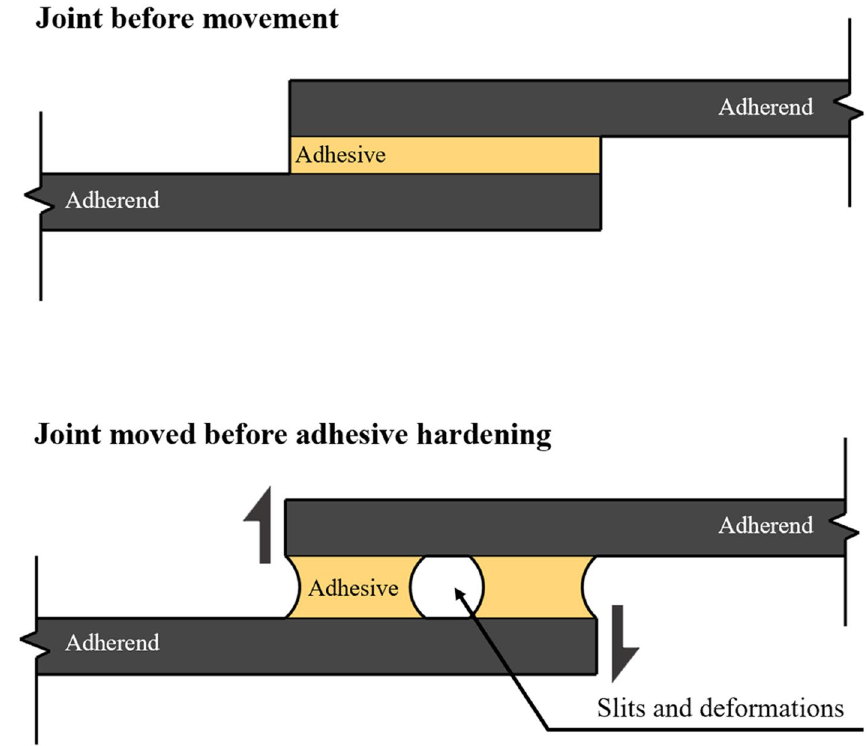
Fig. 8 Void in adhesive bond line most probably caused by moving the joint before the adhesive had reached a suf- ficient cure